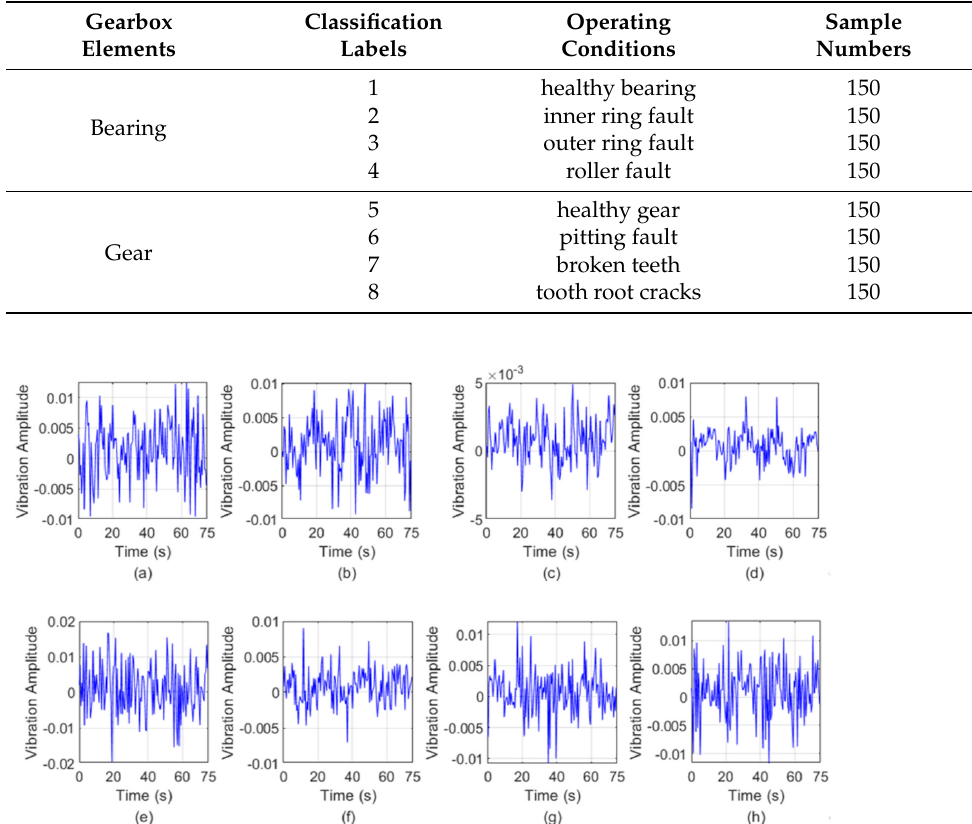
Figure 17. Complete workflow of the proposed hybrid gearbox fault diagnosis method. Table 9. Eight working conditions of a gearbox included in the experimental datasets [43].